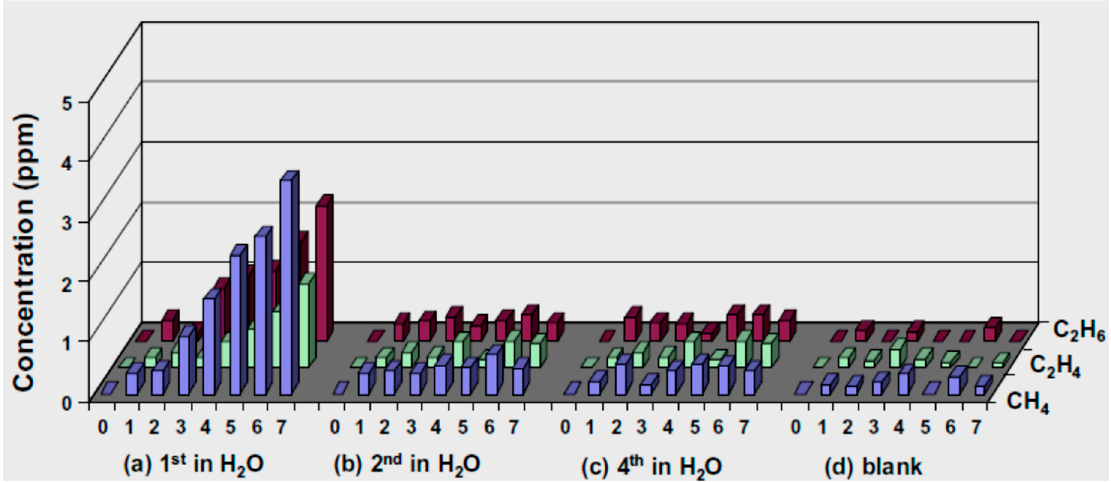
Figure 2. ( a – c ) production of CH 4 , C 2 H 6 , and C 2 H 4 over Ti-SBA-15 for four cycles, and ( d ) blank test (without catalyst). After every cycle reactor was evacuated with He/H 2 O, reproduced with permission from reference [5]. Copyright Elsevier, 2011.